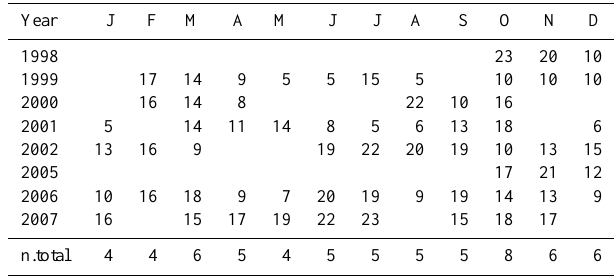
Table 1. Statistics of SATI